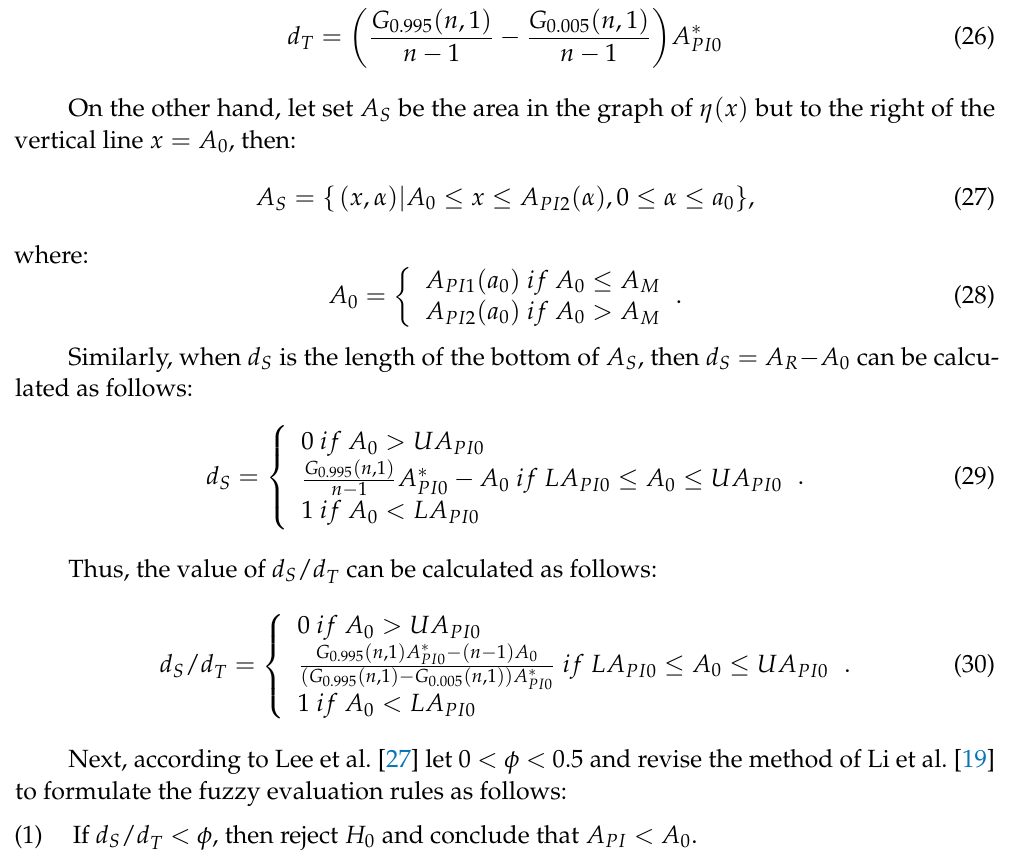
0 x A = . Figure 2. The membership function η 0